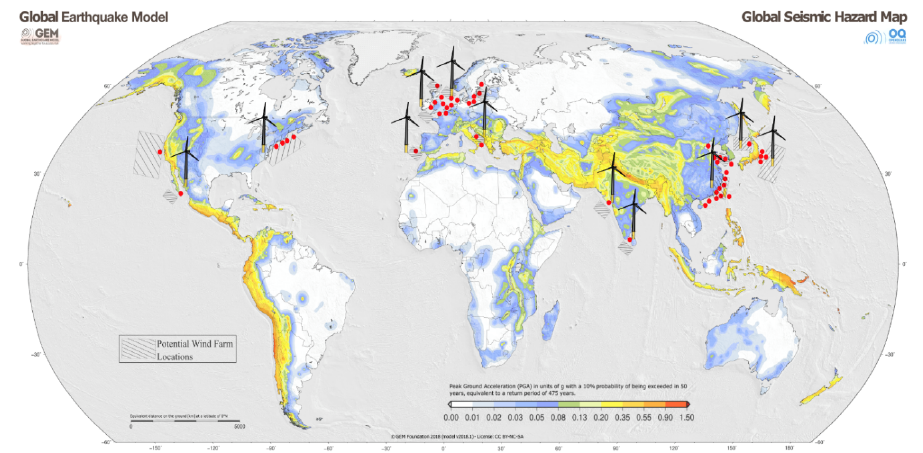
Figure 1. Location of planned and proposed offshore wind farms with seismicity [1].